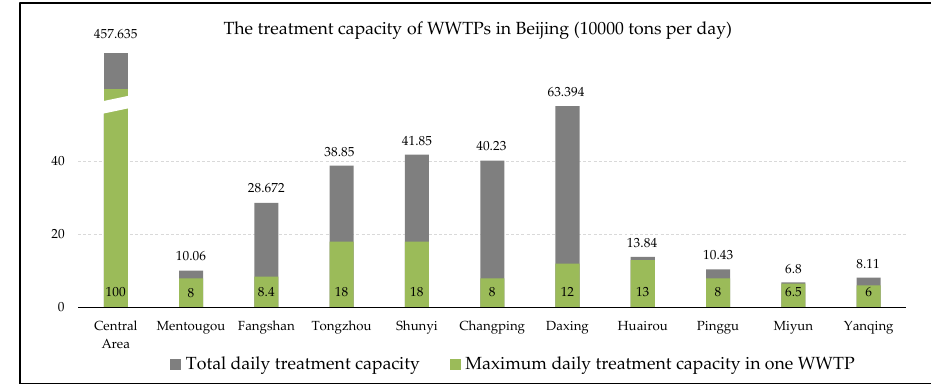
Figure 2. The spatial distribution and treatment capacity of WWTPs in Beijing.